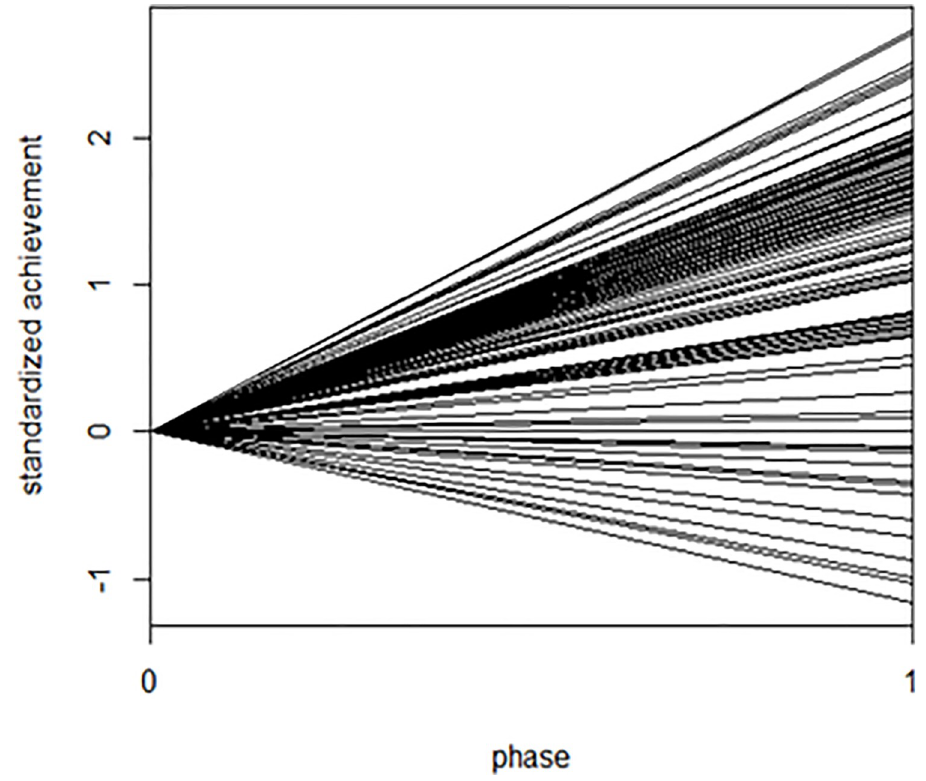
Fig 2. Effect sizes across